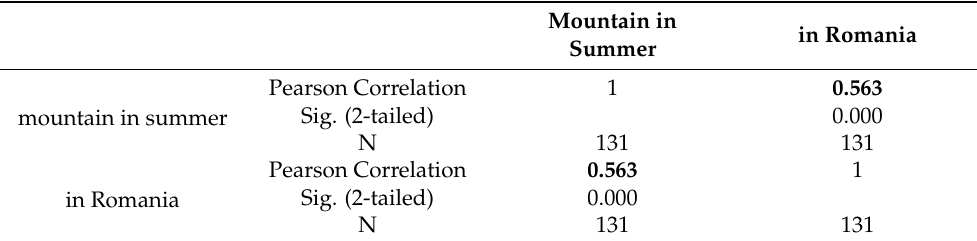
Table 2. Strong, positive connection between those who choose mountain destinations during the summer and those who choose mountain destinations in Romania. Mountain in